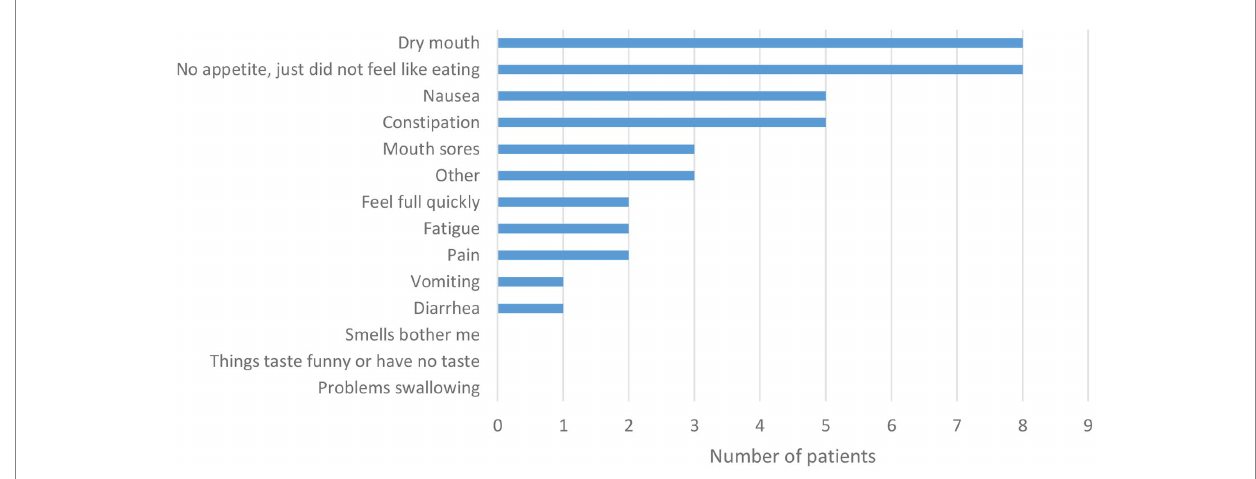
FIGURE 1 The effect of various symptoms on food intake. The X-axis indicates the number of patients that had recorded specific symptoms in reply to the Patient-Generated Subjective Global Assessment Short Form question (PG-SGA-SF). “ I have had the following problems that have kept me from eating enough during the past 2 weeks ” ( n = 22).